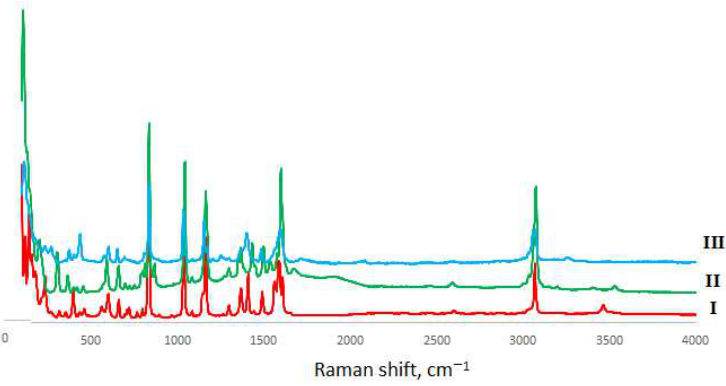
Figure 5. Raman spectra of o -phthalatocuprates.